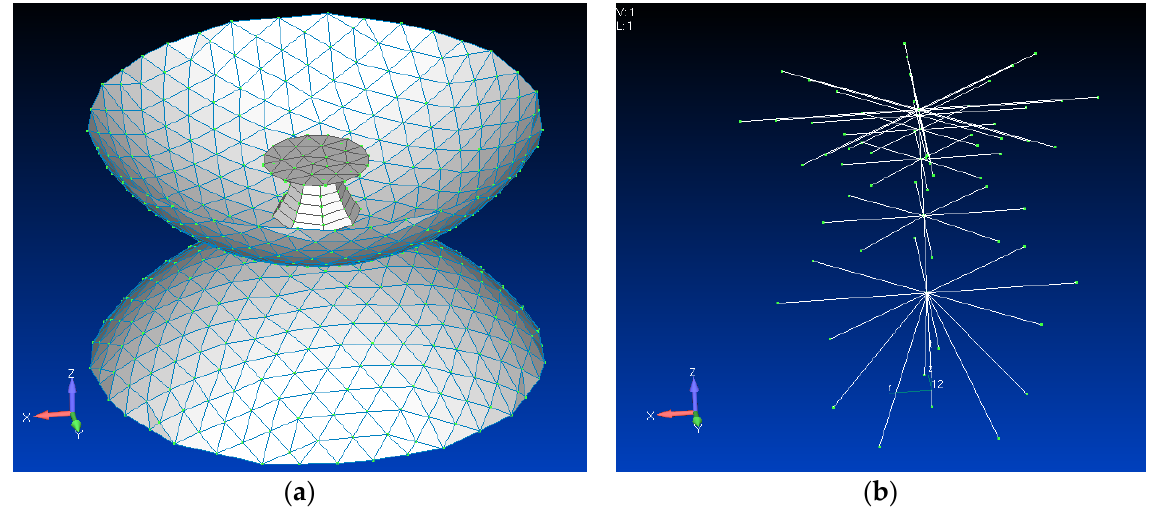
Figure 16. Model of orbital thermal analysis: ( a ) the whole system; ( b ) the heat transfer channel. Table 4. Thermo-physical properties of the model.